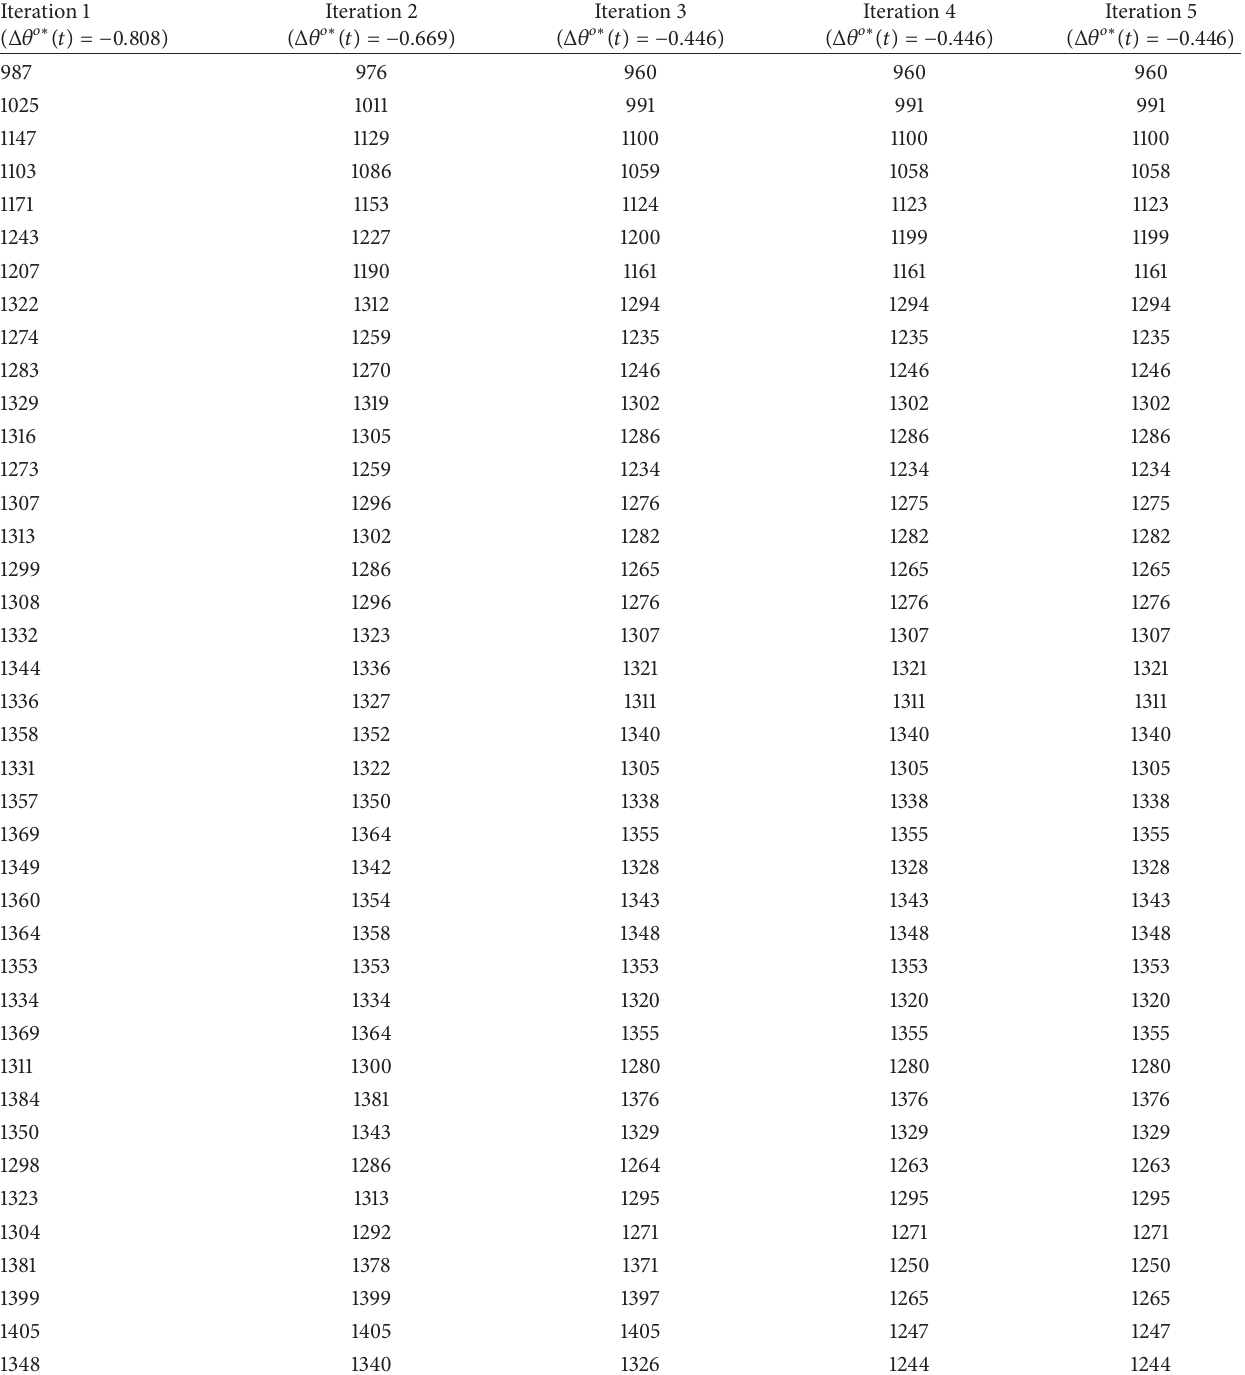
Table 9: The results of the five